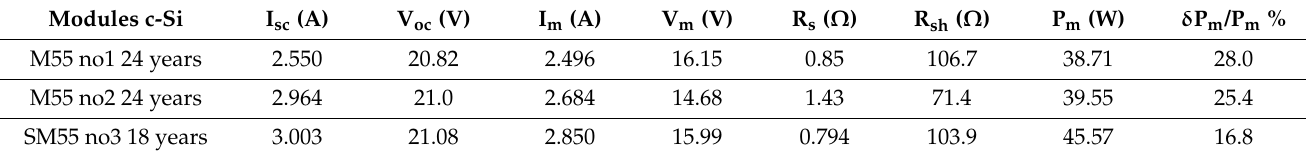
Table 2. The electrical parameters, converted to STC, of two c-Si modules operating for 24 years with induced ageing from extended shading and another c-Si module operating for 18 years under natural